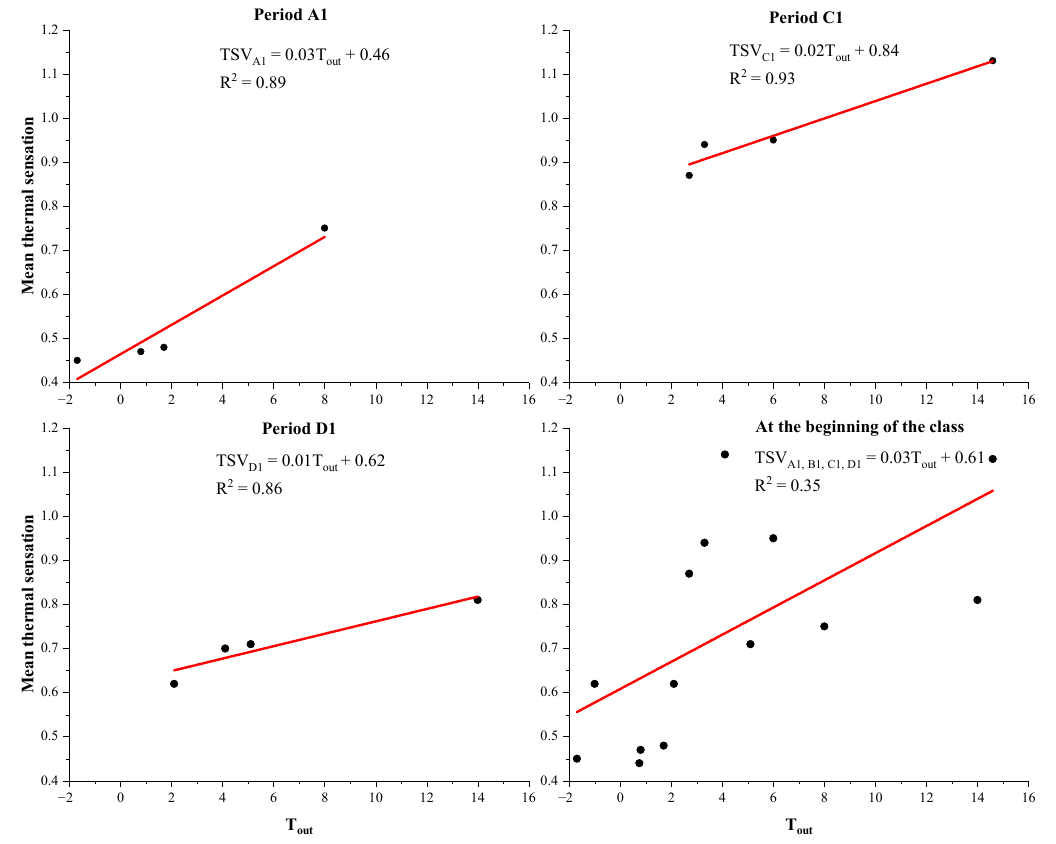
Figure 11. Relationship between TSV and outdoor temperature. Note: Owing to the insufficient sample size of periods B1 and B2, the data of the two periods were not analyzed. At the beginning of the class, there was no significant correlation between TSV and